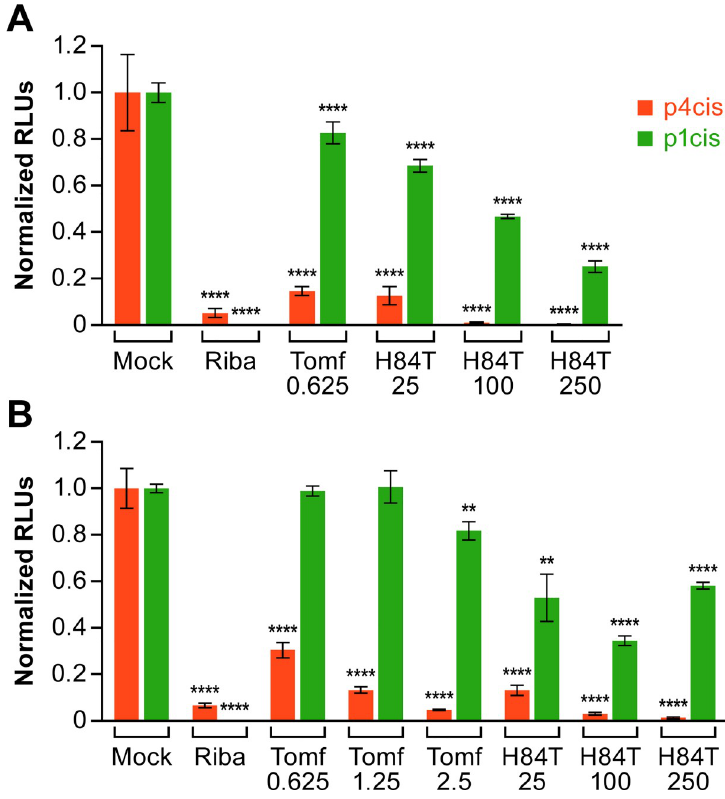
Fig 5. H84T blocks Ebola virus genome transcription/replication, but less potently than it blocks infection by trVLPs. (A) Parallel sets of 293T/17 cells (one set of trVLP target cells and one set of untransfected cells, at 50–75% confluency) were pretreated for 1 h at 37˚C with ribavirin (Riba, 50 μ g/mL), Toremifene (Tomf, 0.625, μ M), or H84T (25, 100, or 250 μ M) and maintained in the same concentration of inhibitor for the remainder of the experiment. After the preincubation period, trVLPs were either added to the trVLP target cells for the p4cis “trVLP infection” assay (red bars) or cells were transfected with the p1cis monocistronic mini-genome and associated RNP plasmids, for the p1cis “genome replication” assay (green bars). Luciferase activity was measured 48 h post infection or transfection. Both assays are described in the Methods section. (B) A repeat experiment was conducted as in (A), but with the addition of two higher concentrations of toremifene (1.25 and 2.5 μ M). Data are the averages of triplicate samples, and error bars represent SD of the triplicate means. Asterisks indicate ( �� ) p < 0.01 and ( ���� ) p < 0.0001, based on two-tailed student t-tests, relative to respective mock treated